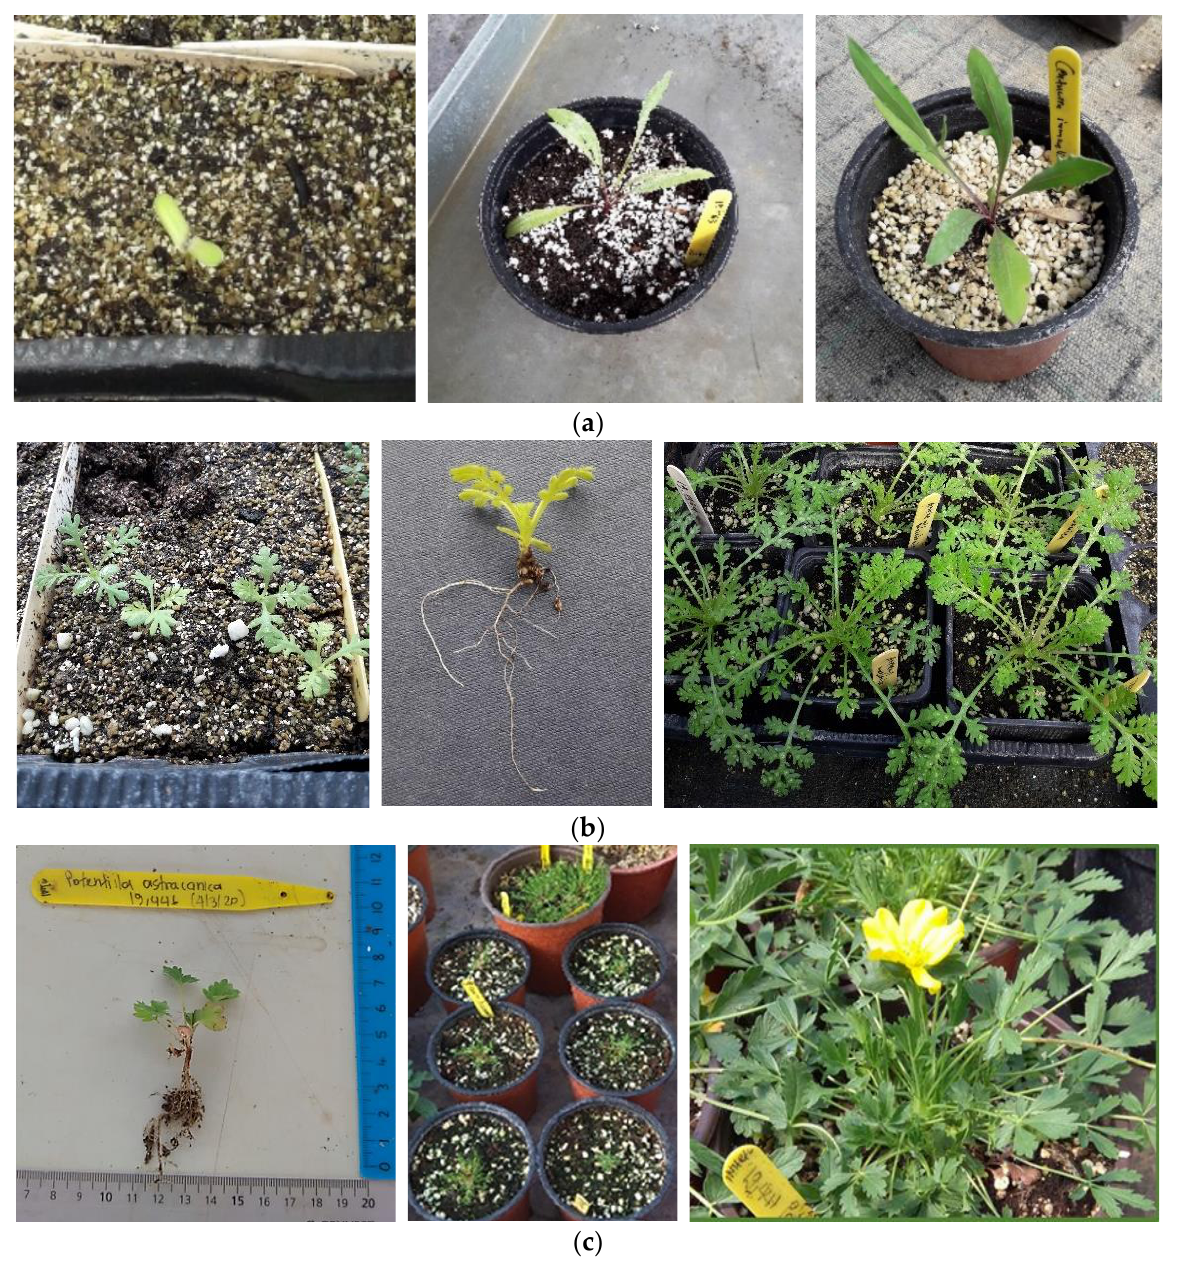
Figure 7. Representative photos of sexual propagation via seeds (germinated seedlings, young seedling root development, transplanted seedlings, mature individuals) of wild-growing plants in different conservation priority categories. ( a ) Priority A1 taxon Centaurea immanuelis-loewii (Rosaceae) with accession number 19,583; ( b ) Priority B4 taxon Anthemis macedonica subsp. macedonica (Asteraceae) with accession number 19,964; ( c ) Priority C1 taxon Potentilla astracanica subsp. astracanica (Rosaceae) with accession number 19,441.